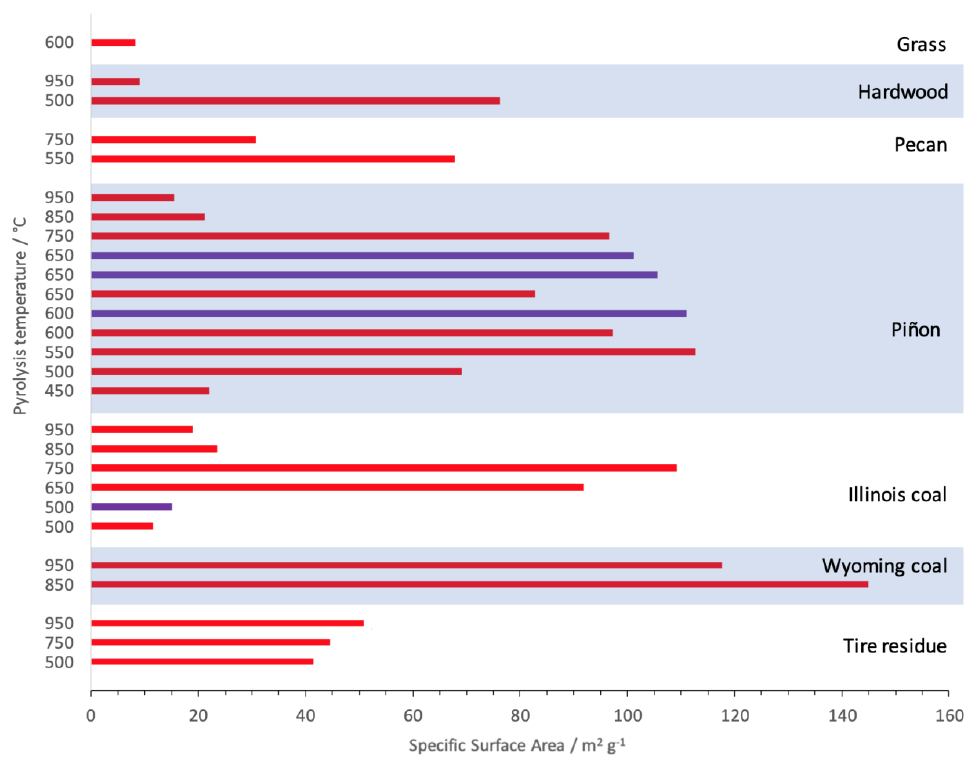
Figure 8. Summary of surface area data for samples prepared in the tube furnace at the indicated pyrolysis temperatures under flowing nitrogen (red bars) or flowing 0.11% (vol.) oxygen in nitrogen (purple bars). All data are normalized to the mass of the feedstock before pyrolysis. Another important metric for adsorbents, particularly when considering liquid ad- sorption, is their total available pore volume. This is measured from the nitrogen ad- sorption isotherm near saturation (i.e., how much nitrogen is adsorbed as the pressure approaches atmospheric pressure) [35]. The pore volume data is shown in Figures 9 and 10, normalized to mass of activated carbon and mass of raw feedstock, respectively. Tire residue proved to have the highest pore volume of all the materials tested. Given its moderate SSA, the high pore volume suggests that the pores formed in pyrolyzed tire residue are larger than those in the biosolid materials. Similar observations were made for SSA in terms of pore volume variations with pyrolysis temperature and the oxygen content of the pyrolysis gas [36].